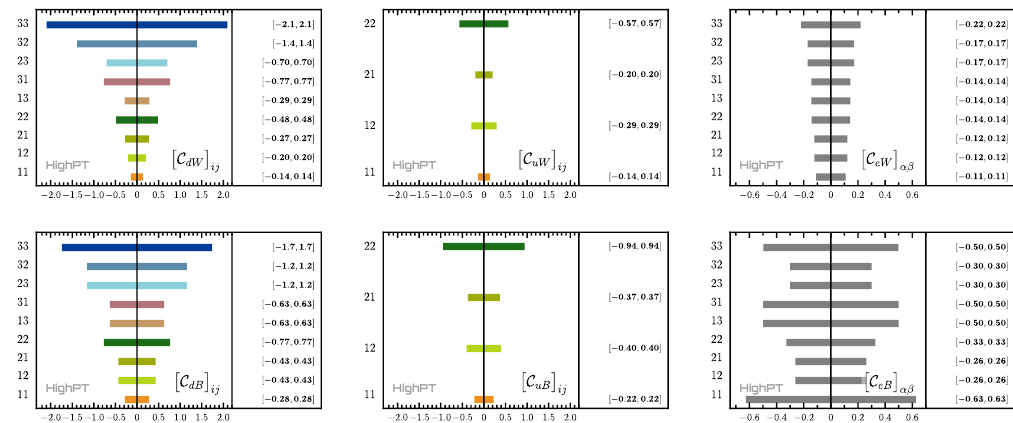
Figure 5. LHC constraints on the SMEFT dipole Wilson coefficients with different flavor indices at 95% CL, where a single coefficient is turned on at a time. Quark (lepton) flavor indices are denoted by ij ( αβ ) and are specified on the left-hand side of each plot. All coefficients are assumed to be real and contributions to the cross-section at order O (1 / Λ 4 ) are considered. The scale Λ is fixed to 1 TeV